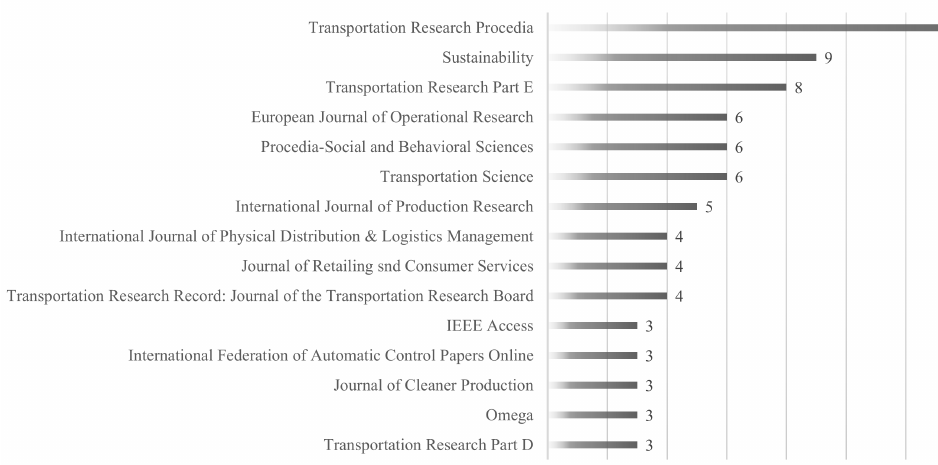
Figure 1. Top 15 journals according to the number of